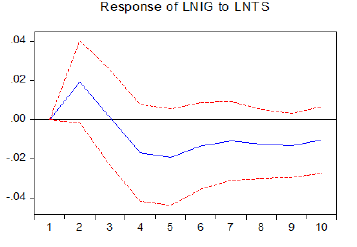
Fig.1. The response path of urbanization to the urban-rural income gap.